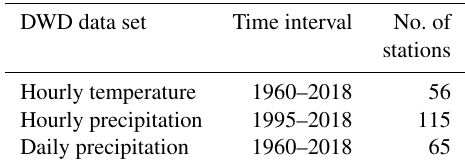
Table 1. DWD data sets used in clustering.